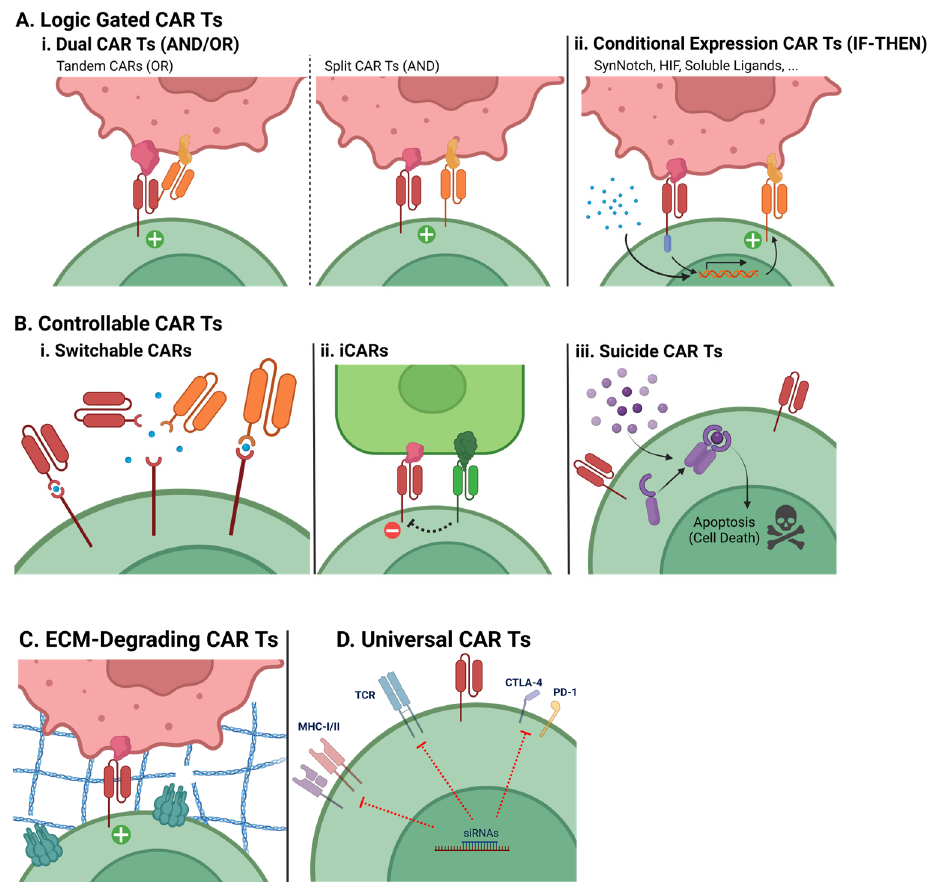
Figure 4. Visual representation of special CAR T engineering designs. Receptor endodomain regions are represented simplistically as a single straight line in the cytoplasmic part of the depicted mem- brane proteins. The plus (+) sign signifies full CAR T activation signaling, and the minus ( − ) sign signifies inhibition of CAR activation signaling.